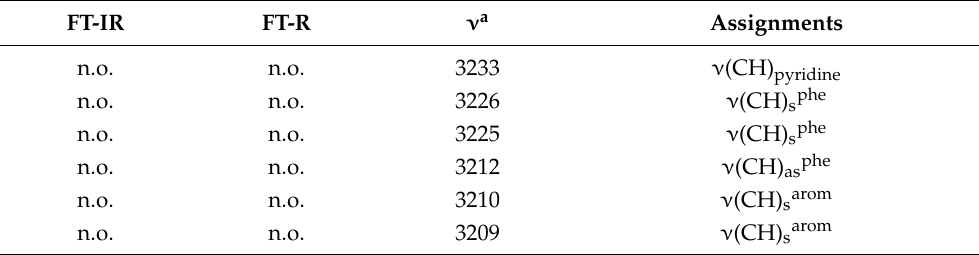
Table 3. Comparison of the experimental infrared and Raman bands of PPL9 with the theoretical harmonic wavenumbers ( ν a , cm − 1 ) calculated for PPL9 by the B3LYP method with 6-31G (d,p) basis set. FT-IR FT-R ν a Assignments n.o. n.o. 3233 ν (CH) pyridine n.o. n.o. 3226 n.o. n.o. 3225 ν (CH) sphe n.o. n.o. ν (CH) asphe n.o. n.o.